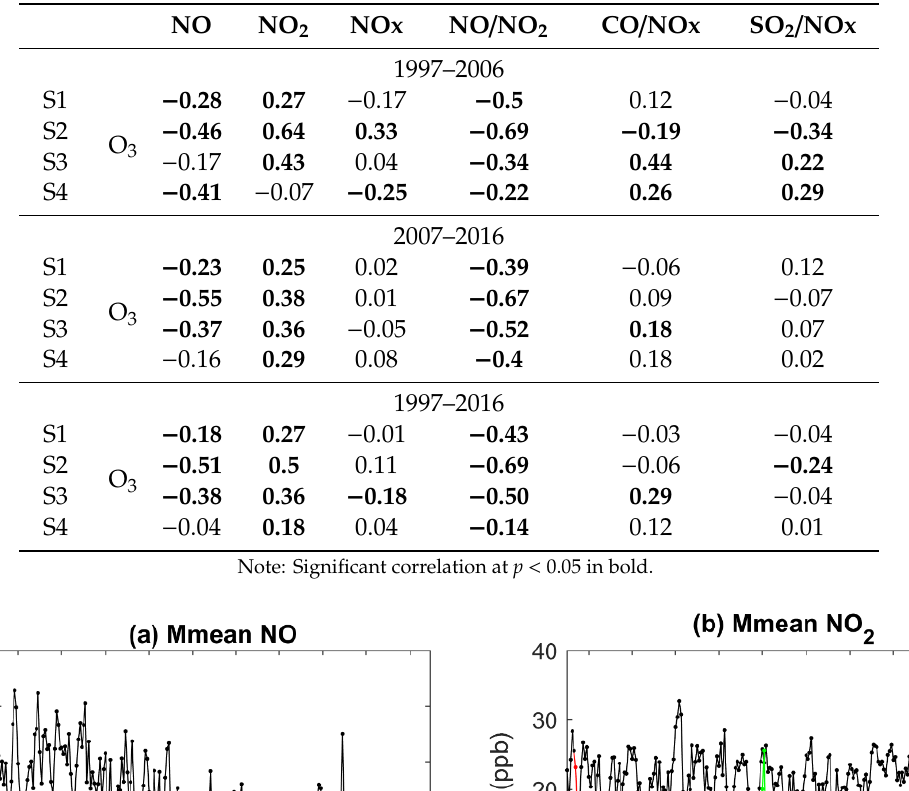
Table 3. Spearman’s Rank-Order Correlation of Mmean O 3 .